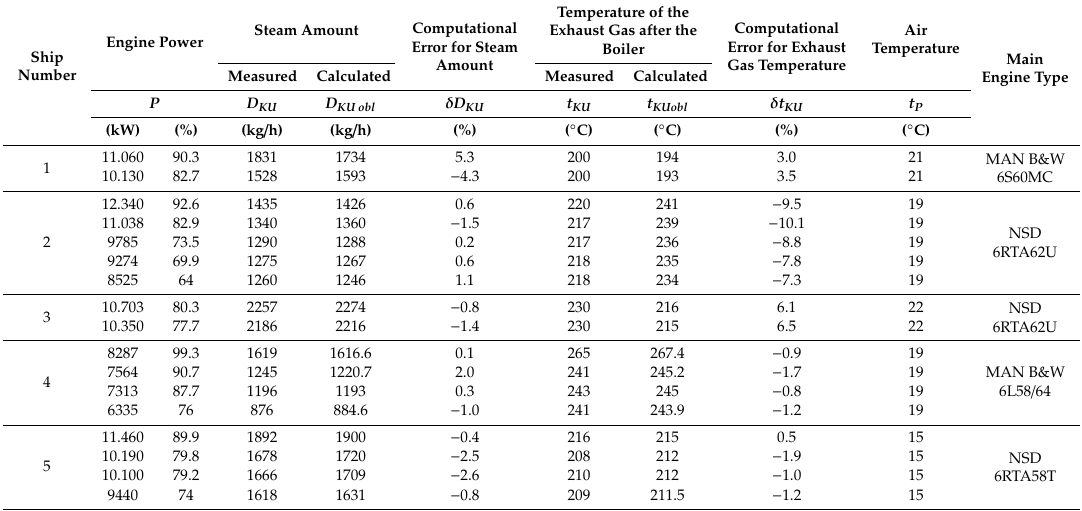
Table 2. Comparison of measured and calculated work parameters of an exhaust gas boiler.